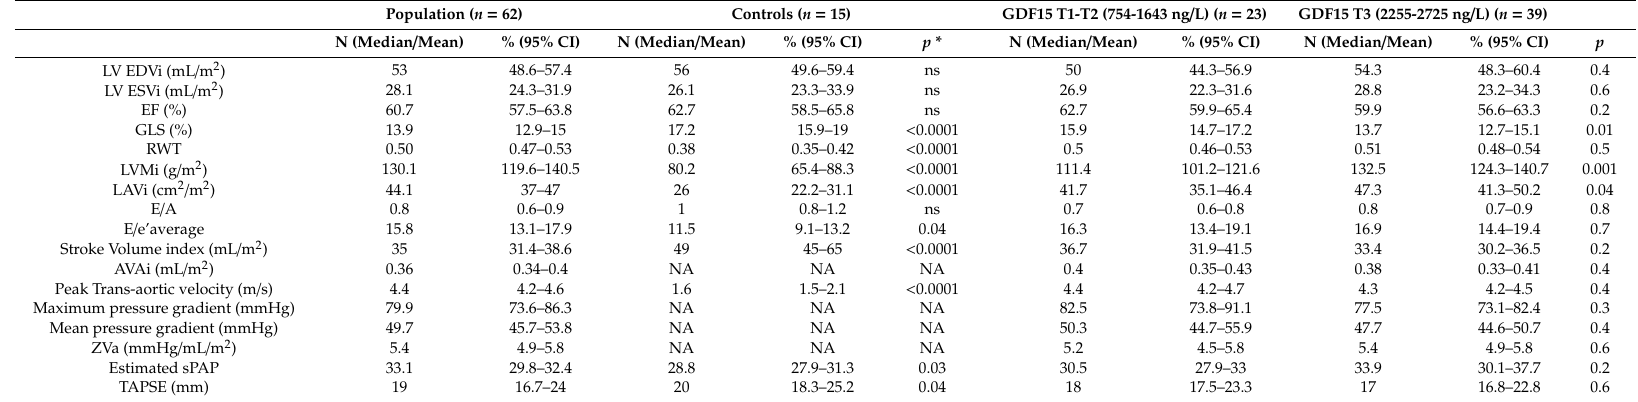
Table 2. Echocardiographic parameters (whole population, controls, and GDF15 tertiles